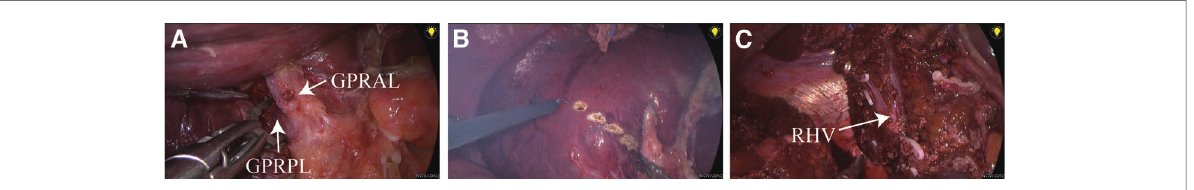
FIGURE 1 Surgical procedure for laparoscopic anatomical right posterior lobe resection (using the extrahepatic glissonean approach). ( A ) The Glissonean pedicle of the right posterior lobe (GPRPL) was identi fi ed, dissected free and then occluded with a bulldog clamp. ( B ) The extent of resection was determined according to the ischemic line, and an electrocoagulation hook was used to draw a pretransected line. ( C ) The right posterior lobe of the liver was removed, and the right hepatic vein trunk was preserved. GPRAL, Glissonean pedicle of right anterior lobe; GPRPL, Glissonean pedicle of right posterior lobe; RHV, right hepatic vein.